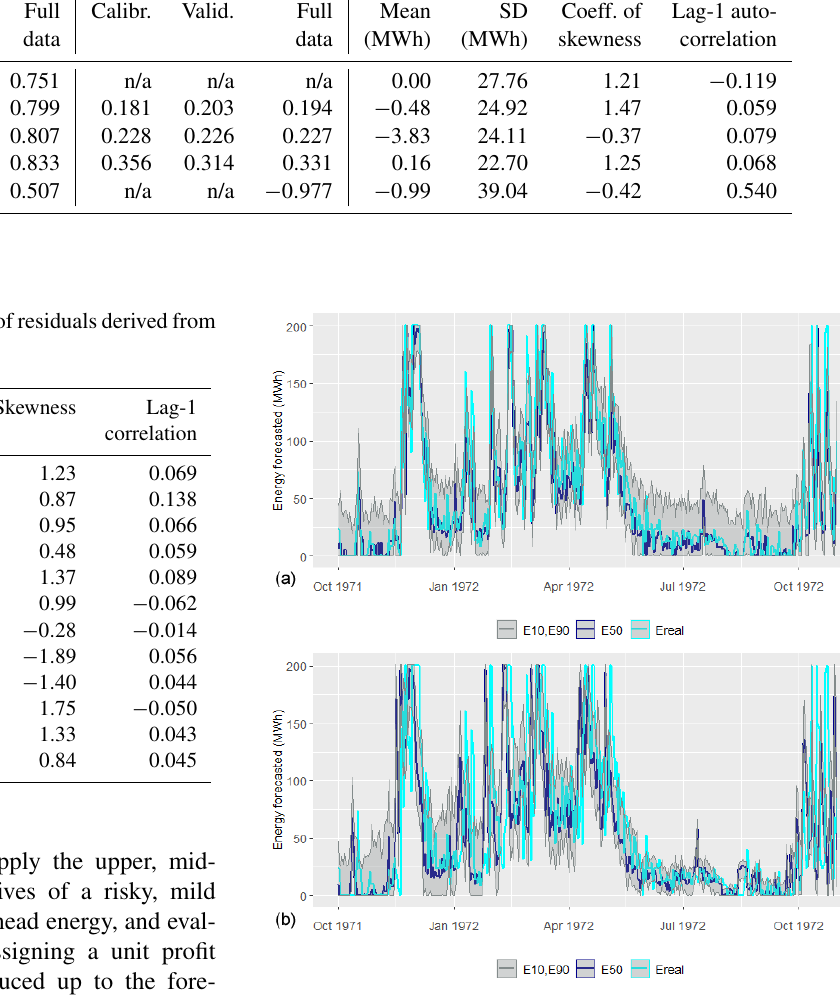
Figure 5. Comparison of actual energy production for hydrolog- ical year 1972–1973 with three characteristic prediction quantiles (10%, 50% and 90%), by considering the error process as: (a) sta- tionary and (b)